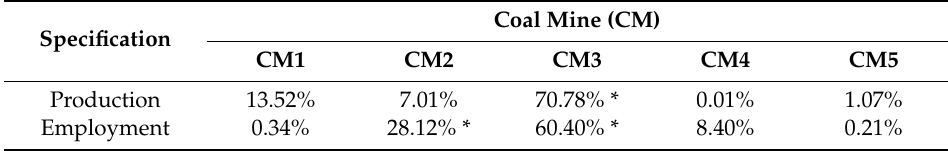
Table 5. Determination coe ffi cients ( ϕ 2 ) between total costs and production volume and employment.